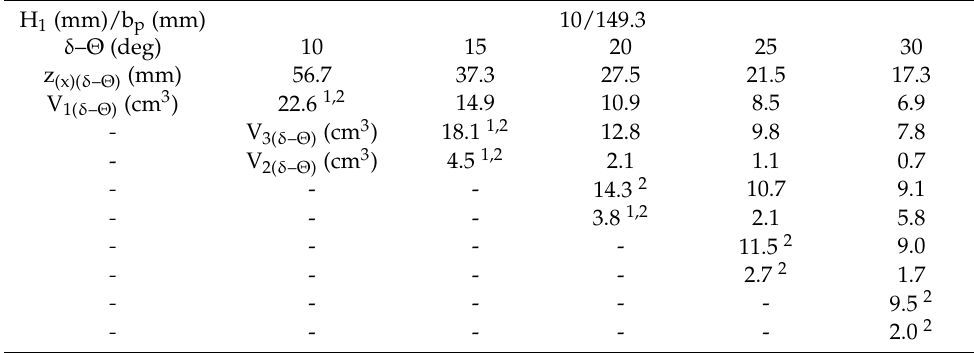
Table 2. Volume of material V i( δ – Θ ) [cm 3 ] for H 1 = 10 mm belt